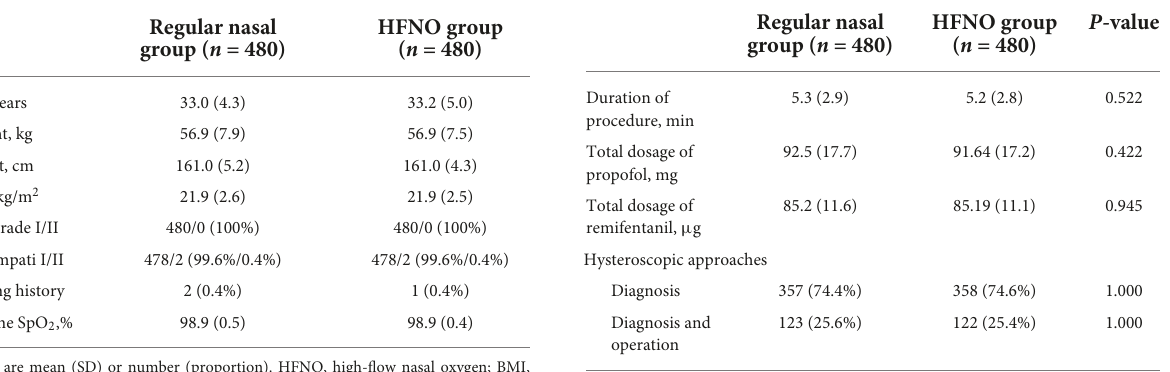
minimum SpO 2 was 98% [12% (53–100%)]; in the HFNO group, it was 100% [0% (86–100%)] ( P < 0.001; Figure 4 ).